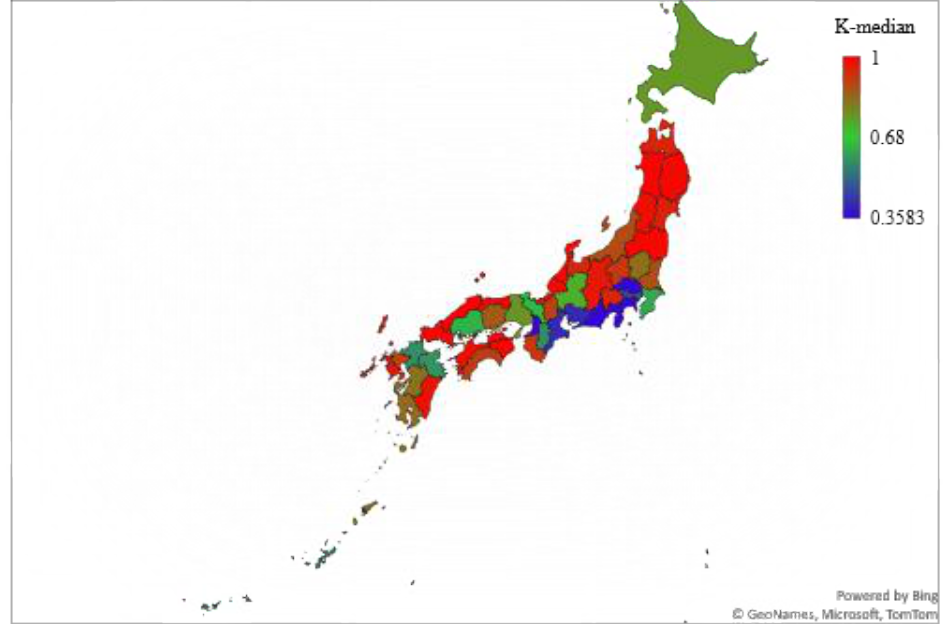
Figure 6. K-median values from 0 – 1 test for cities/prefectures of Japan for data until 8 October 2021.